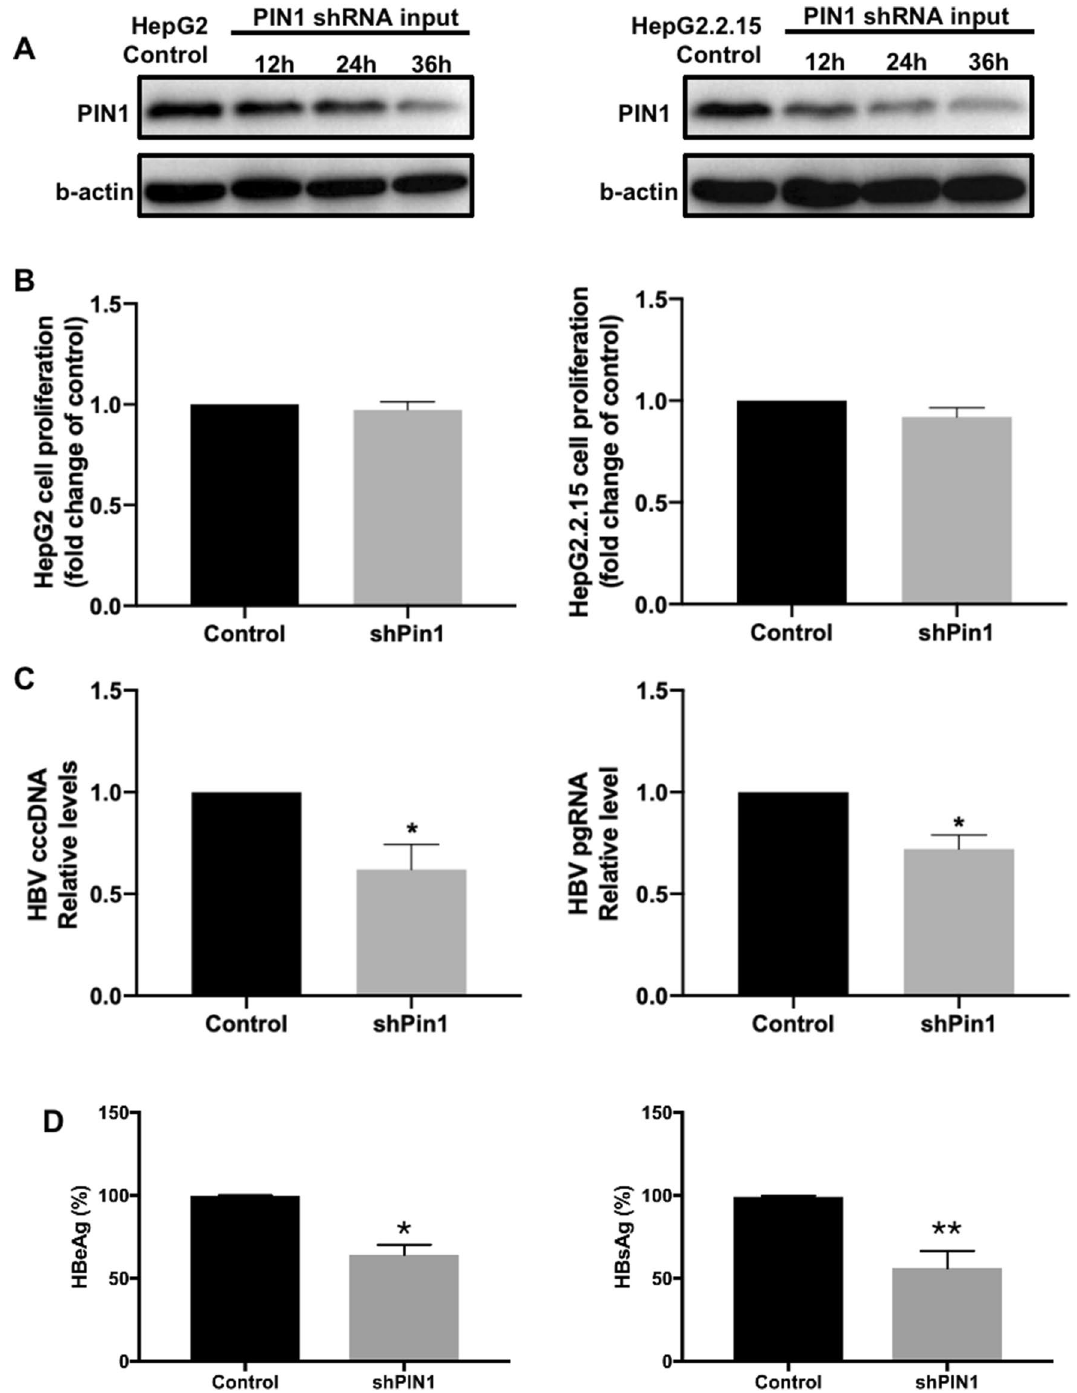
Figure 4. The role of Pin1 in HBV replication and HBx enhanced HBV replication. Levels of Pin1 expression detected by Western Blot after transfected with Pin1 shRNA for 12 h, 24 h, and 36 h in HepG2 and HepG2.2.15 cells ( A ). Cell proliferation of HepG2 and HepG2.2.15 cells were detected by CCK8 kit after transfected with Pin1 shRNA for 36 h and compared with un-treated control group ( B ). HepG2.2.15 cells were transfected with Pin1 shRNA for 36 h, levels of HBV cccDNA and pgRNA in cell-culture supernatant were detected by qPCR ( C ) and levels of HBeAg and HBsAg in cell culture supernatant were detected using ELISA test ( D ) and compared with control group. Data shown are the means ± SD from three parallel experiments. Statistical significance was examined by one-way analysis of variance pairwise comparison. p < 0.05 was considered statistically significant; *: P < 0.05; **: P < 0.01; ***: P <